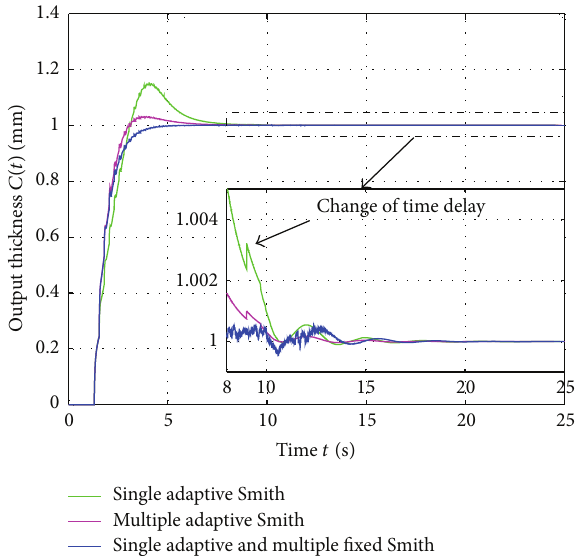
Figure 10: Multiple Smith prediction model for system with jump- ing time